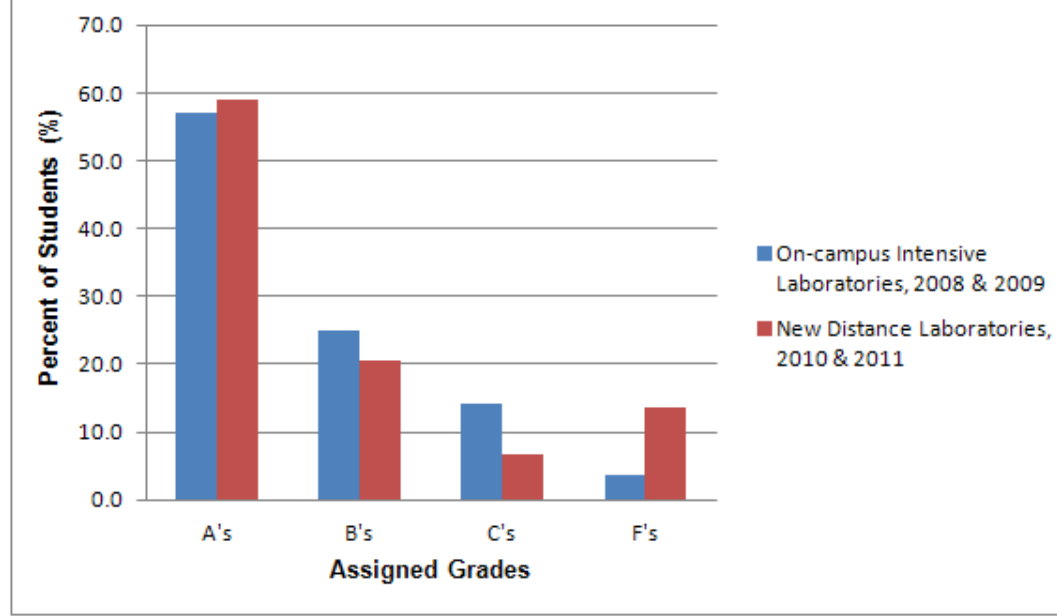
Figure 2. Percentage of students achieving each grade range via the two modes of delivery; on-campus, intensive laboratories in 2008 and 2009, and new, blended, distance laboratories in 2010 and 2011. Assigned grades include all sub-divisions within; for example, A’s include A-, A, and A+ letter grades. F grades include those that did not complete or failed the course, but do not include